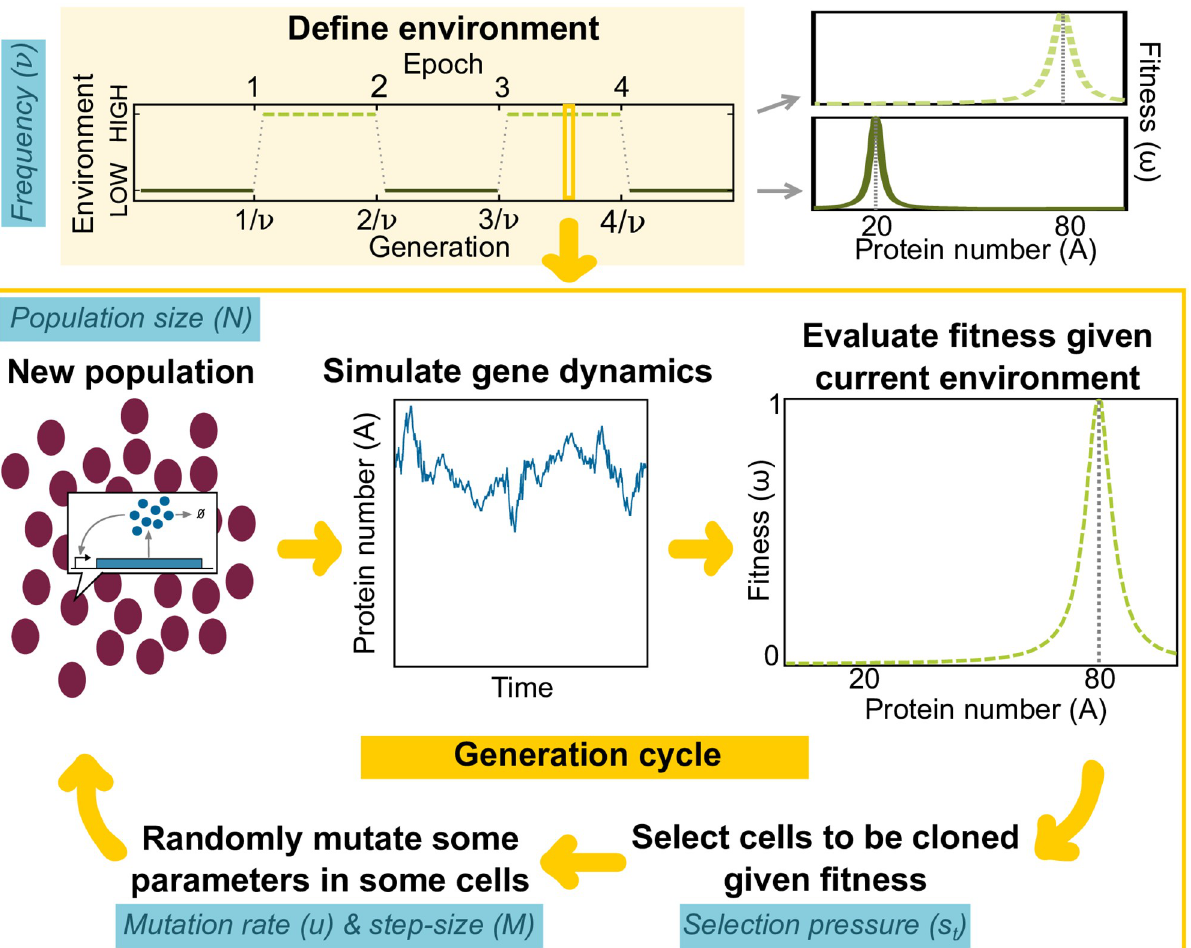
Fig 2. Evolutionary model. The environment fluctuates periodically with frequency ν . The total number of generations spent in a constant environment (epoch) has the same length (1/ ν ) and each environment (HIGH or LOW) selects for a different distribution of protein levels (phenotypes). Each generation, we simulated the stochastic protein dynamics of a self-activating gene in each cell across a population of size N . At the end of each simulation, the population phenotypes varied because gene expression is stochastic and because cells can have different underlying biochemical parameters (genotypes). The current environment in each generation assigned a fitness ( ω ) to each cell ( i ) based on its final protein level. i We used tournament selection (where s t determines the strength of selection) to determine the next generation of cells according to their fitness. Each cell in the next generation was mutated with probability u , where the current set of biophysical parameters were multiplied or divided up to a maximum step-size of M